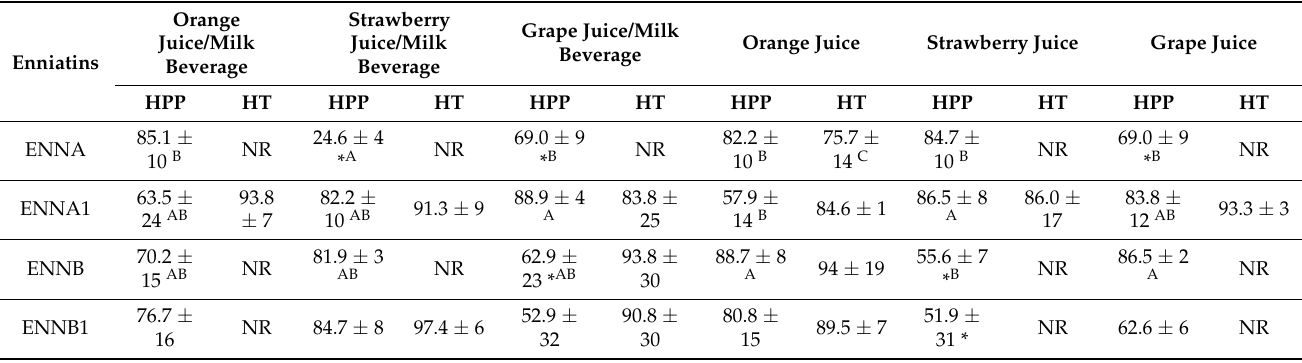
Table 1. Contents of enniatins ( µ g/L) obtained after HPP and HT treatments in the different juice models